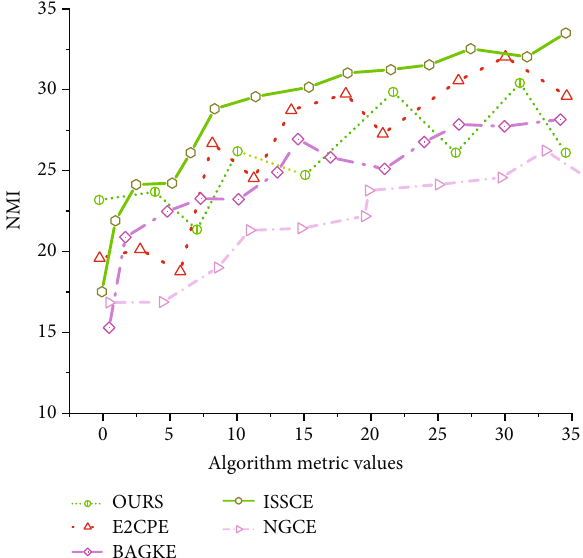
Figure 8: Di ff erent algorithm metric values after adjusting the penalty